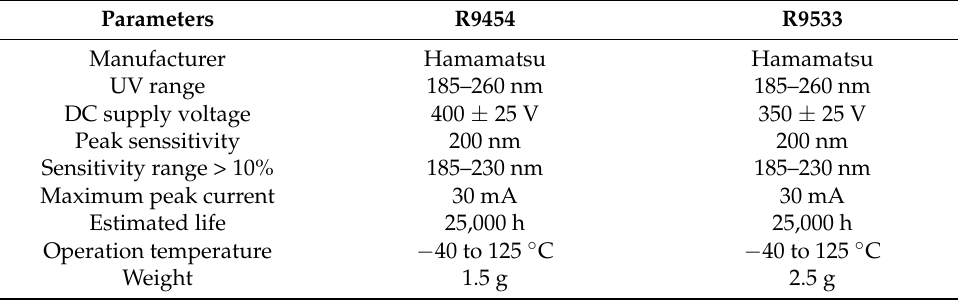
Table 1. Hamamatsu UVTRON sensors analyzed in this